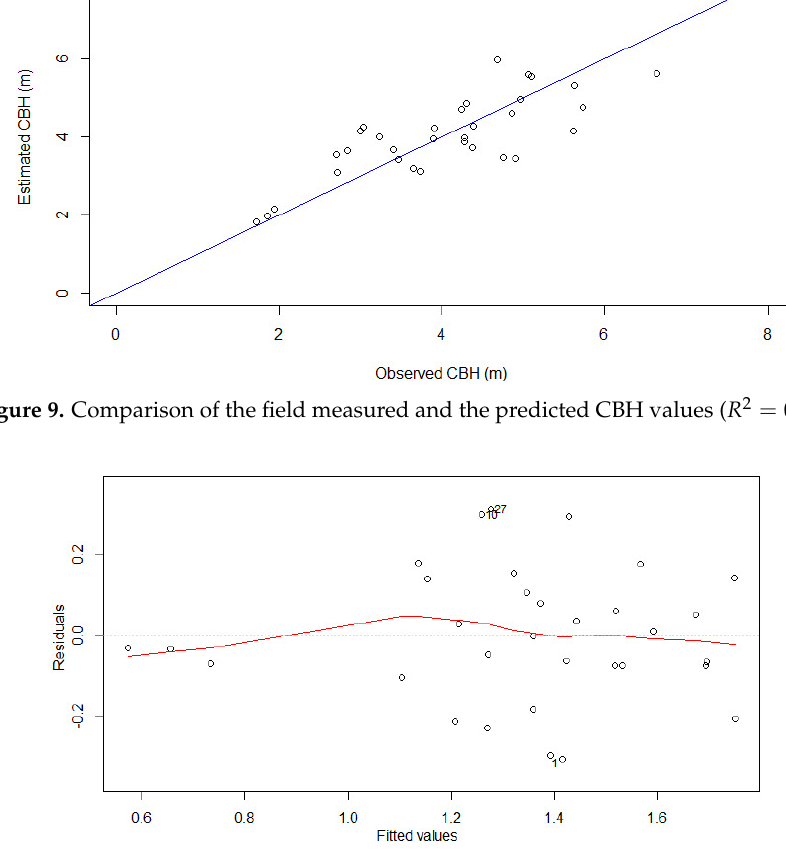
Figure 10. Residuals in the prediction of plot-level CBH using regression analysis.